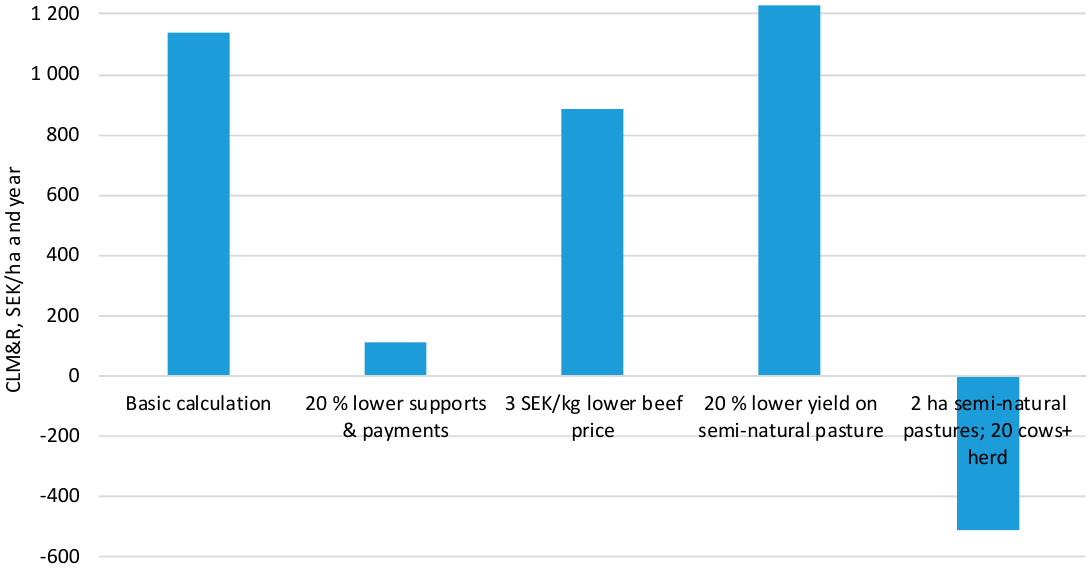
Figure 5. Contribution to land, management, and risk (CLM&R) in the basic calculation for central Sweden and four sensitivity analyses. The herd size is 50 cows + , that is beef suckler cows + rearing of all their calves to slaughter and replacement, except in the case of 2 ha pastures where the herd size is 20 cows+.